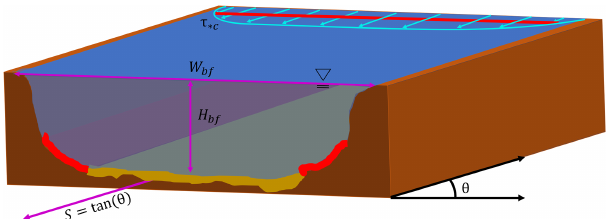
Figure 1. Schematic cross section of a sand-bedded, alluvial river with different bed vs. bank material under bank-full flood condi- tions. Here W bf , H bf , and S are bank-full width, bank-full depth, and channel gradient at the cross section, respectively. Cyan lines at the surface illustrate the horizontal stress profile across the channel. Red lines along the channel bottom indicate the toe of the river- bank, i.e., the intersection of bed and bank material. The red line intersecting the cyan velocity profile indicates the threshold stress of the threshold-limiting material, illustrating that the bank toe is at threshold, while Shields stress in the channel center is slightly in excess of